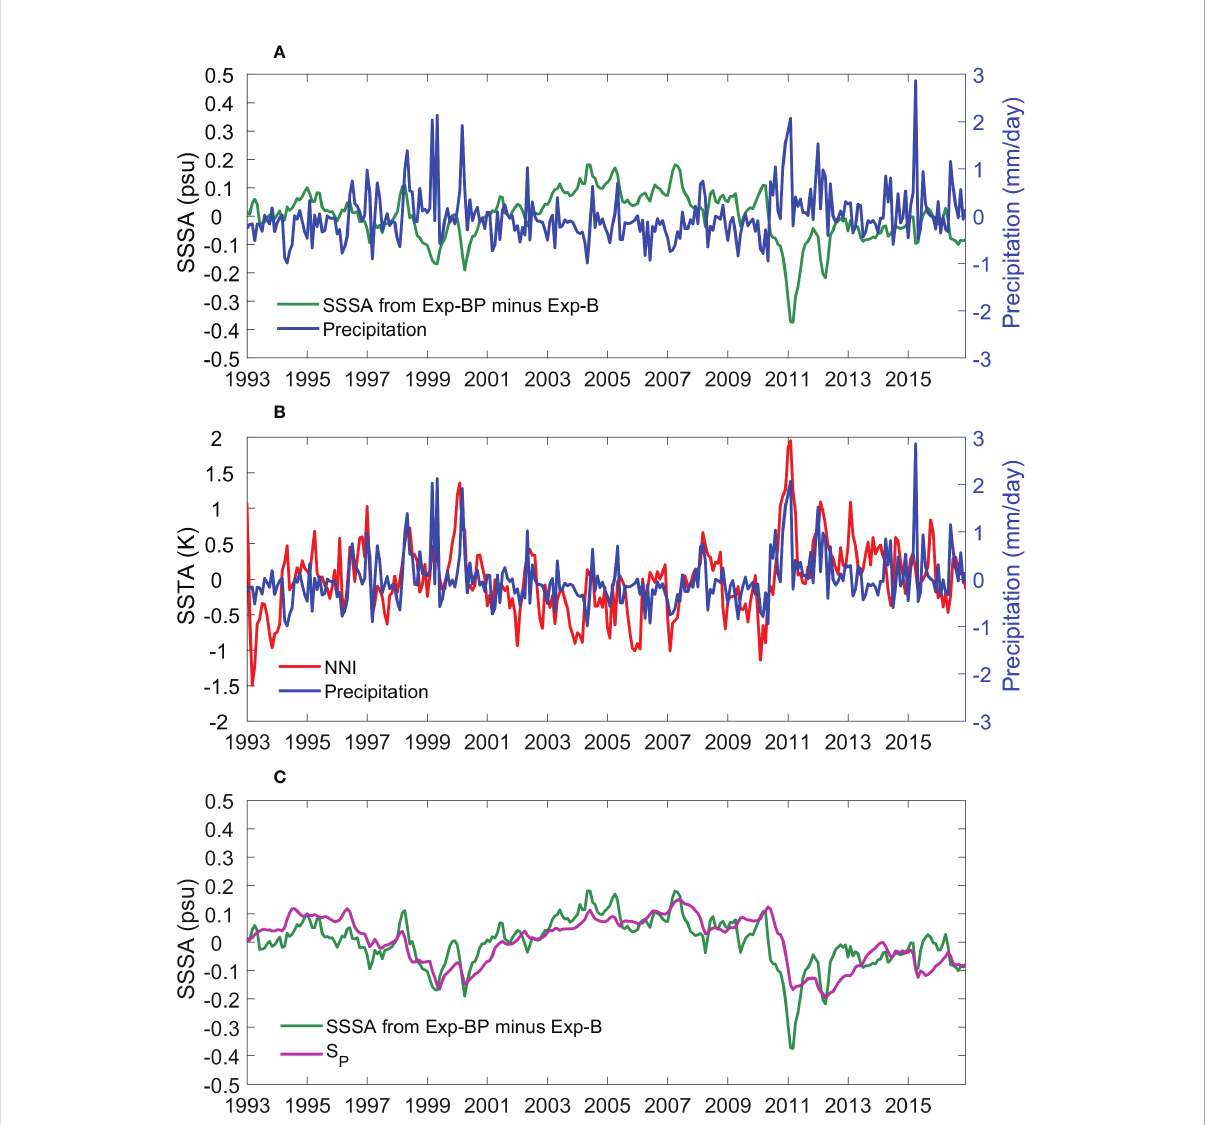
FIGURE 8 (A) Time series of averaged SSSA (psu) from Exp-BP minus Exp-B and surface precipitation anomalies (mm day -1 ) from ERA-Interim for the SEIO region. (B) compares the precipitation anomaly with the Ningaloo Niño index (NNI; in K). NNI is computed as the averaged SST anomaly of the 28 o -22 o S, 108 o E to the coast region (Kataoka et al., 2013). (C) shows the SSSA from Exp-BP minus Exp-B and that simulated by the local rainfall-forced salinity model (LRSM) experiments S P using e = 2.75 × 10 -3 s -1